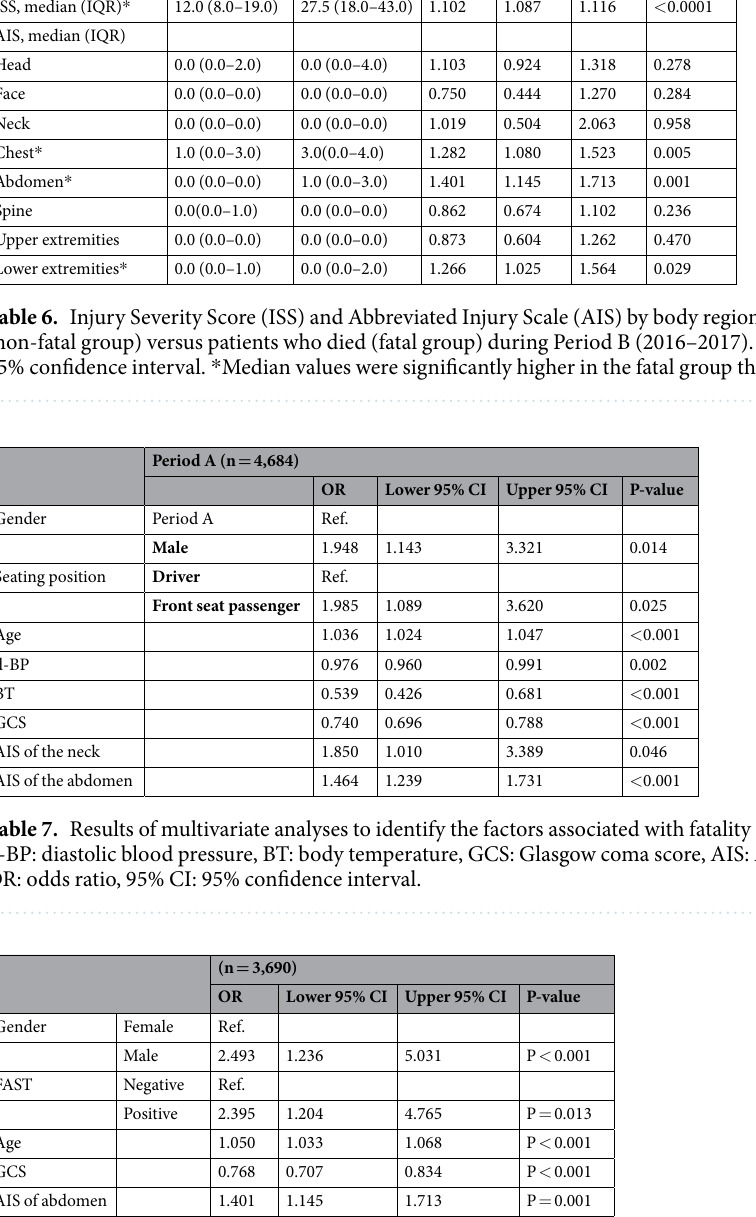
Table 8. Results of the multivariate analyses to identify the factors associated with fatality in Period B (2016– 2017). FAST: focused assessment with sonography for trauma, GCS: Glasgow coma score, AIS: Abbreviated Injury Scale, OR: odds ratio, 95% CI: 95% confidence